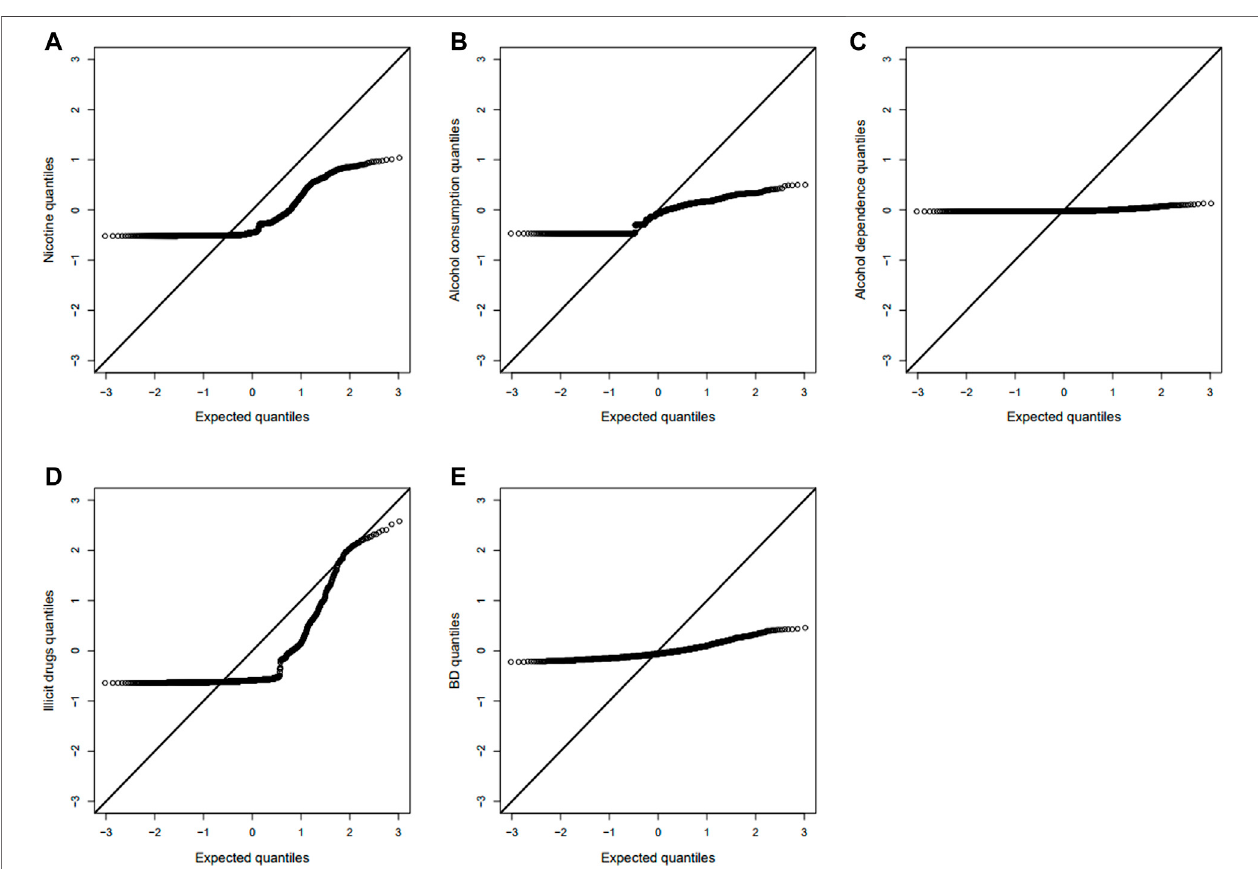
FIGURE 1 | Q-Q plots of fi ve clinical phenotypes ( N = 1,187). (A) Nicotine, (B) alcohol consumption, (C) alcohol dependence, (D) illicit drugs, and (E) BD, non- substance use related behavioral